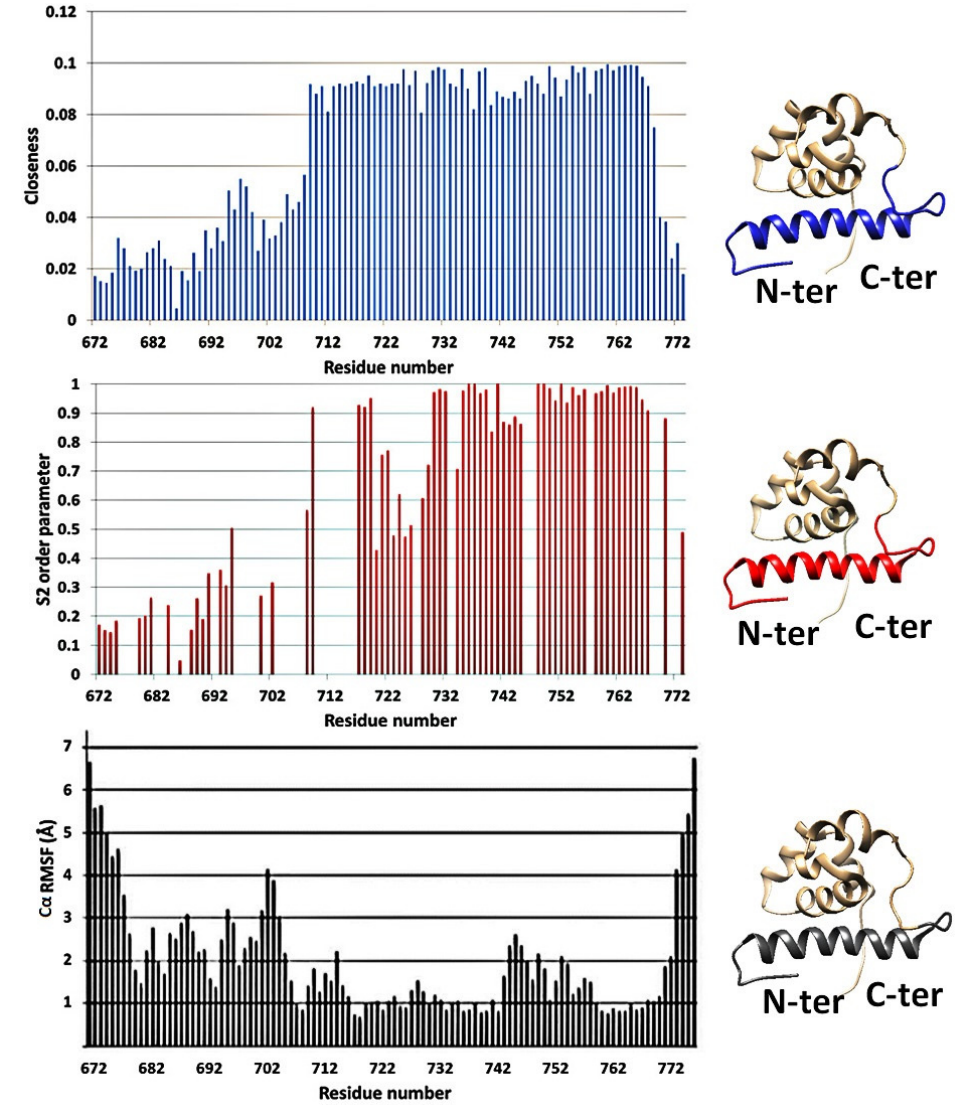
Figure 2. Closeness centrality vs. S 2 relaxation and root mean square fluctuation (RMSF) parameters from molecular dynamic (MD) calculations for the anthrax lethal factor protease core domain (PDB ID: 2L0R) [36]. The colored regions in the 3D structures in the right panel indicate the flexible segments identified by the corresponding technique.